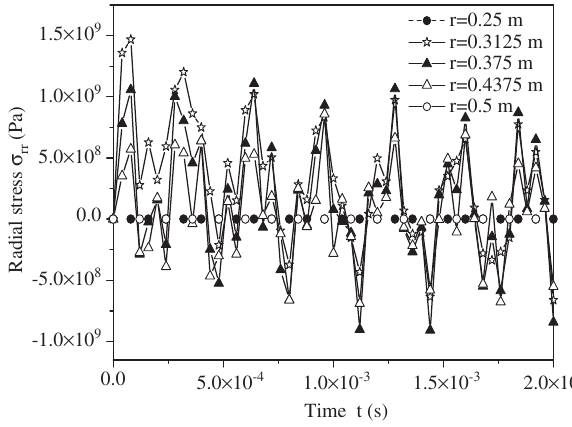
Figure 6 Response histories of radial displacement in the FGM hollow cylinder at different thicknesses, where n = 1.